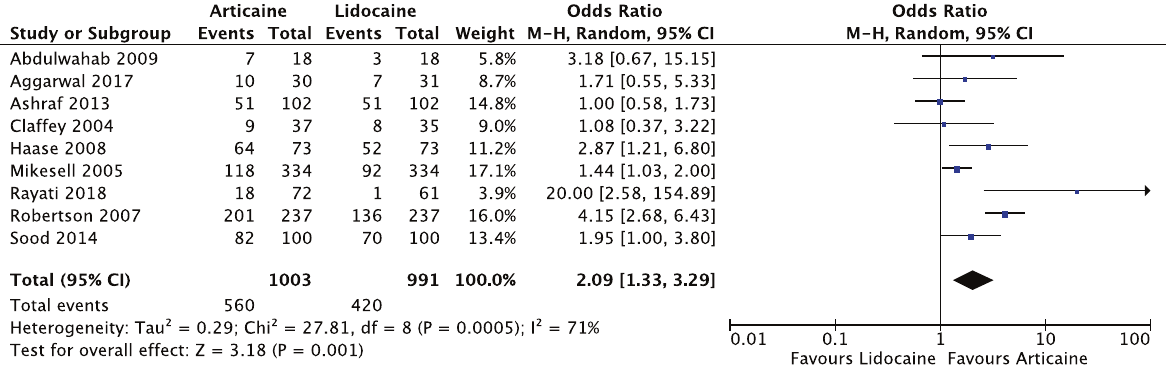
Fig. 10 Forest plot — all mandibular interventions — blocks and in fi ltrations. Articaine had 2.09 times likelihood of anaesthetic success of lidocaine.